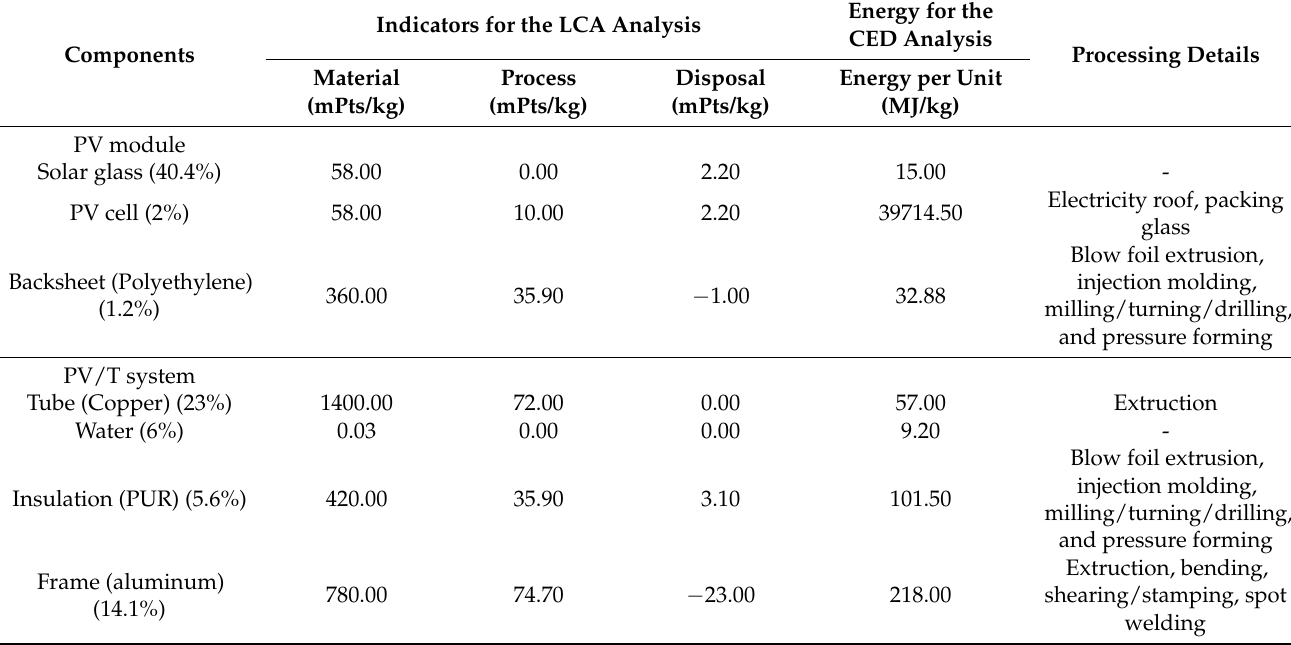
Table 3. The points and energies per unit in kg used in the LCA and CED